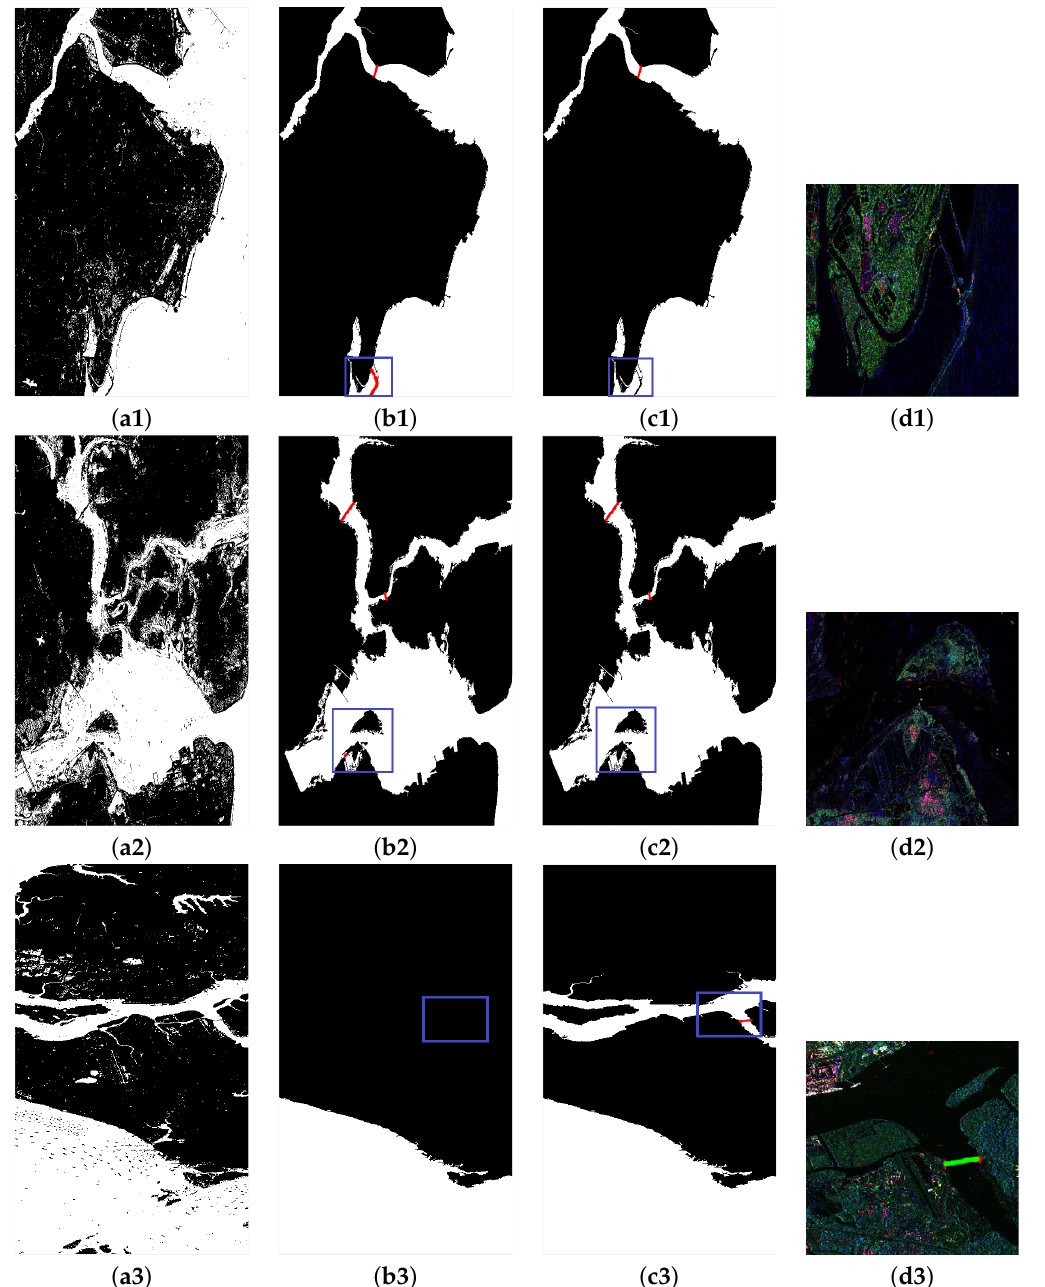
Figure 8. Comparison of the bridge detection results between the proposed method and the spatial method. ( a1 – a3 ) Sea–land segmentation results. ( b1 – b3 ) Results of the spatial detection methods. ( c1 – c3 ) Results of the proposed method. ( d1 – d3 ) The local enlargement of the different detection regions marked in blue boxes in ( b1 – b3 ) and ( c1 – c3 ). ( a1 – d1 ) Results of the Fuzhou data. ( a2 – d2